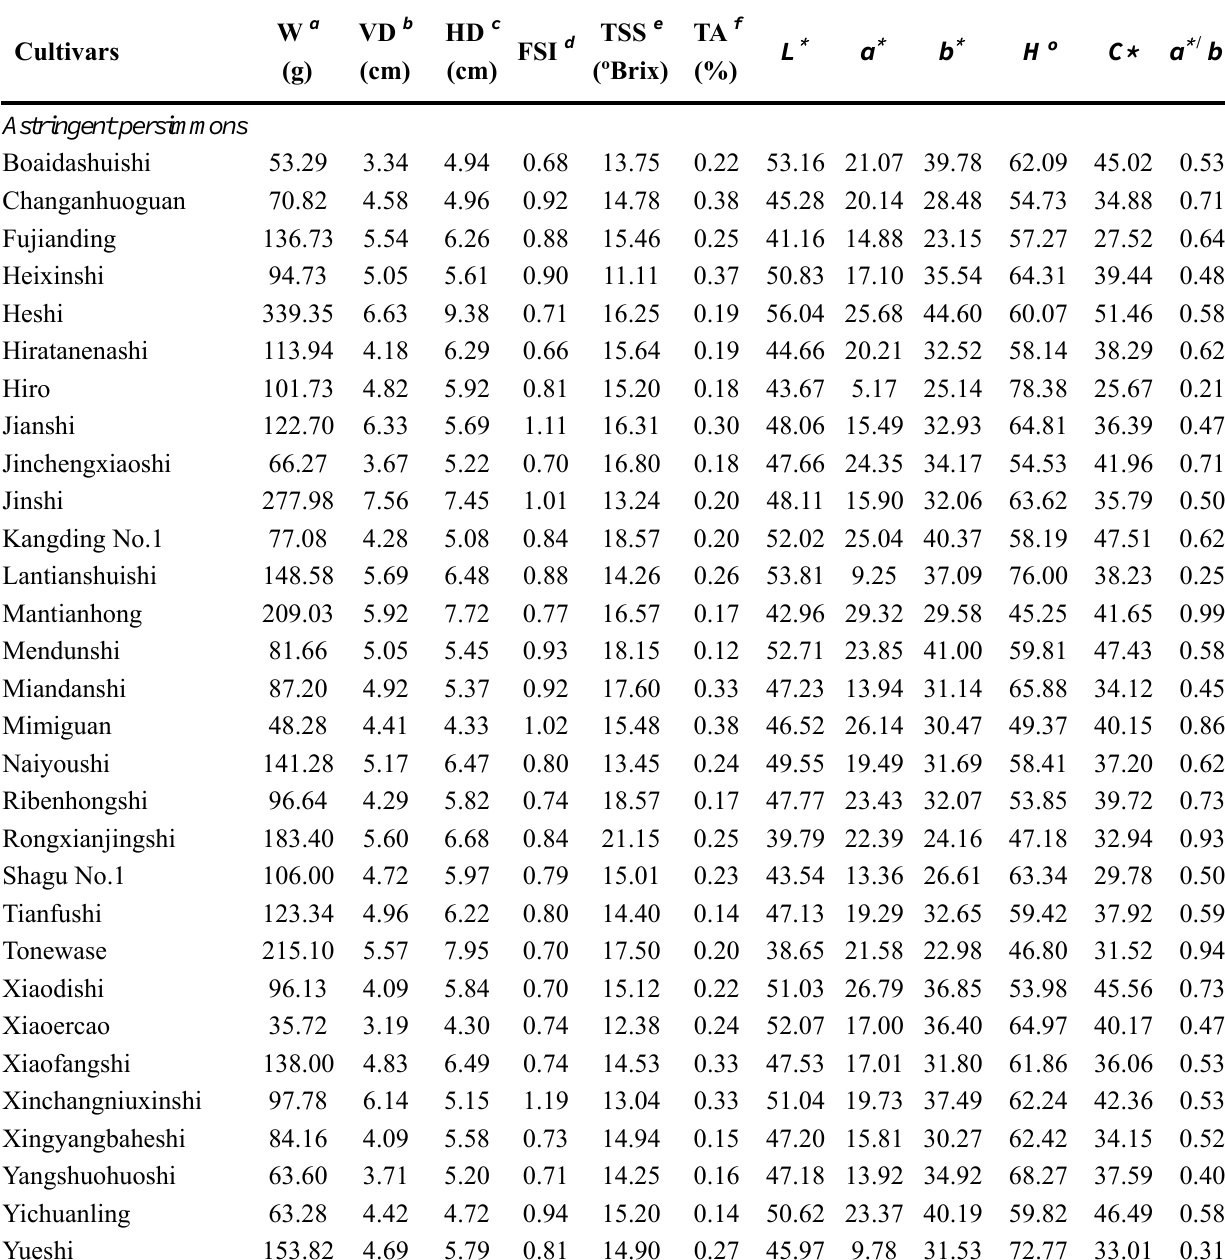
Table 1. Major quality and color indexes in the fleshes of different persimmon cultivars.